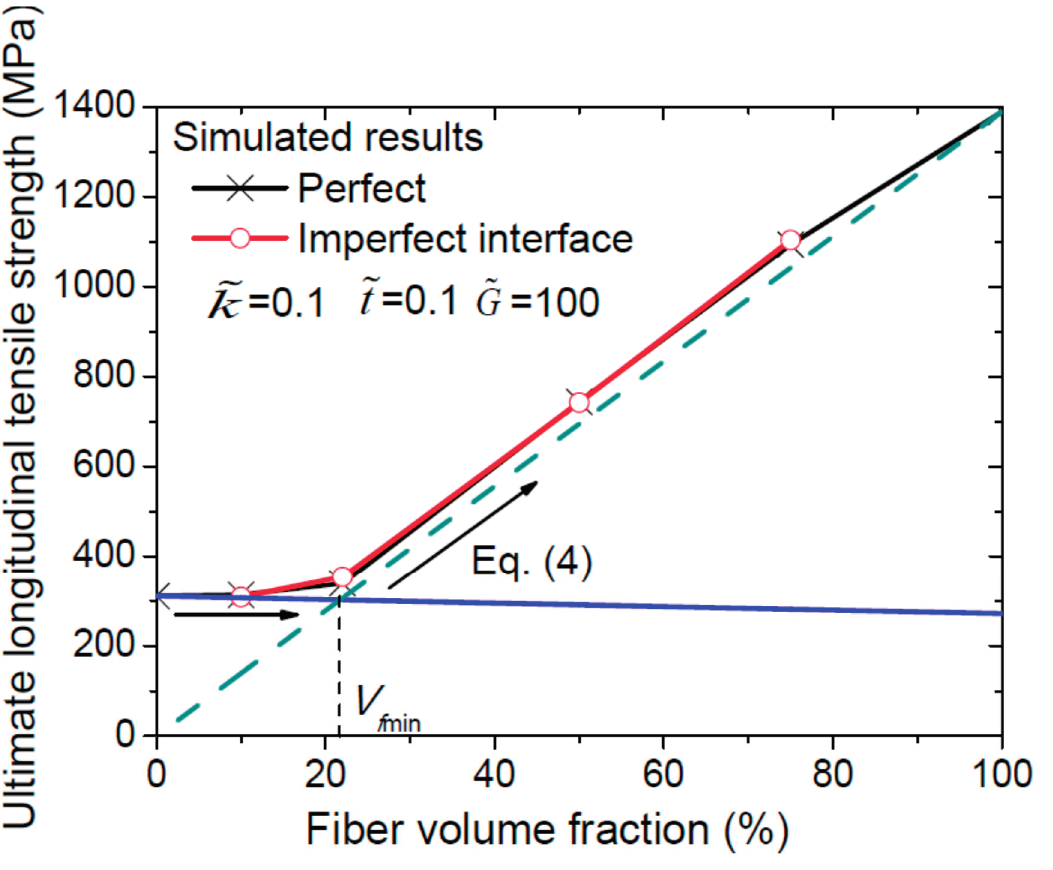
Figure 10. Ultimate longitudinal tensile strengths with respect to the fiber volume fraction. The arrow represents the ultimate longitudinal tensile strength with respect to the fiber volume fraction calculated using Equation